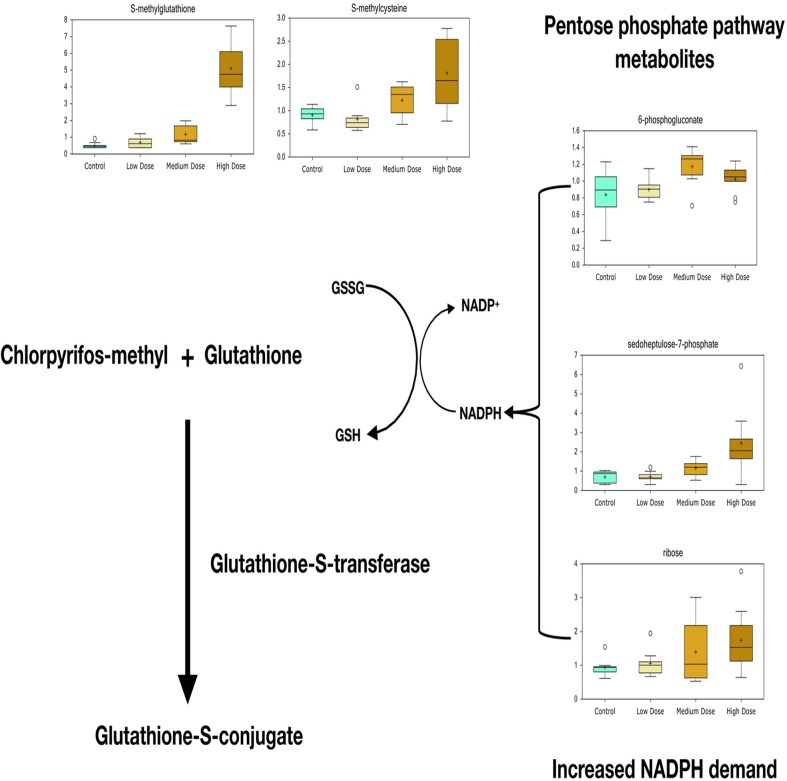
Significant metabolites predict glutathione-S-transferase-mediated detoxification of chlorpyrifos-methyl in liver of Atlantic cod after 30 days of dietary exposure. A high level of pentose phosphate pathway metabolites, including 6-phosphogluconate, sedoheptulose-7-phosphate, and ribose, predicts increased demand for NADPH for reducing power when the glutathione detoxification system is active.